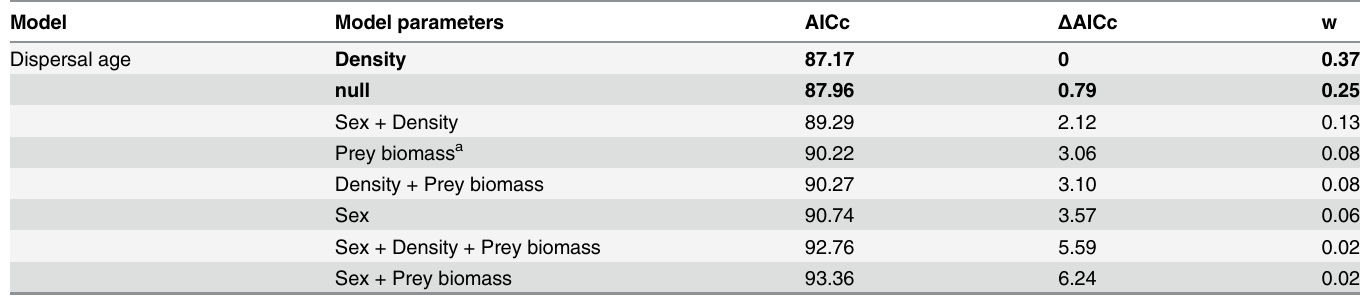
Table 2. A priori linear models exploring the effect of sex, time as a proxy for population density and prey biomass density on age at commence- ment of dispersal in subadult leopards in Phinda Game Reserve, South Africa, 2002 –